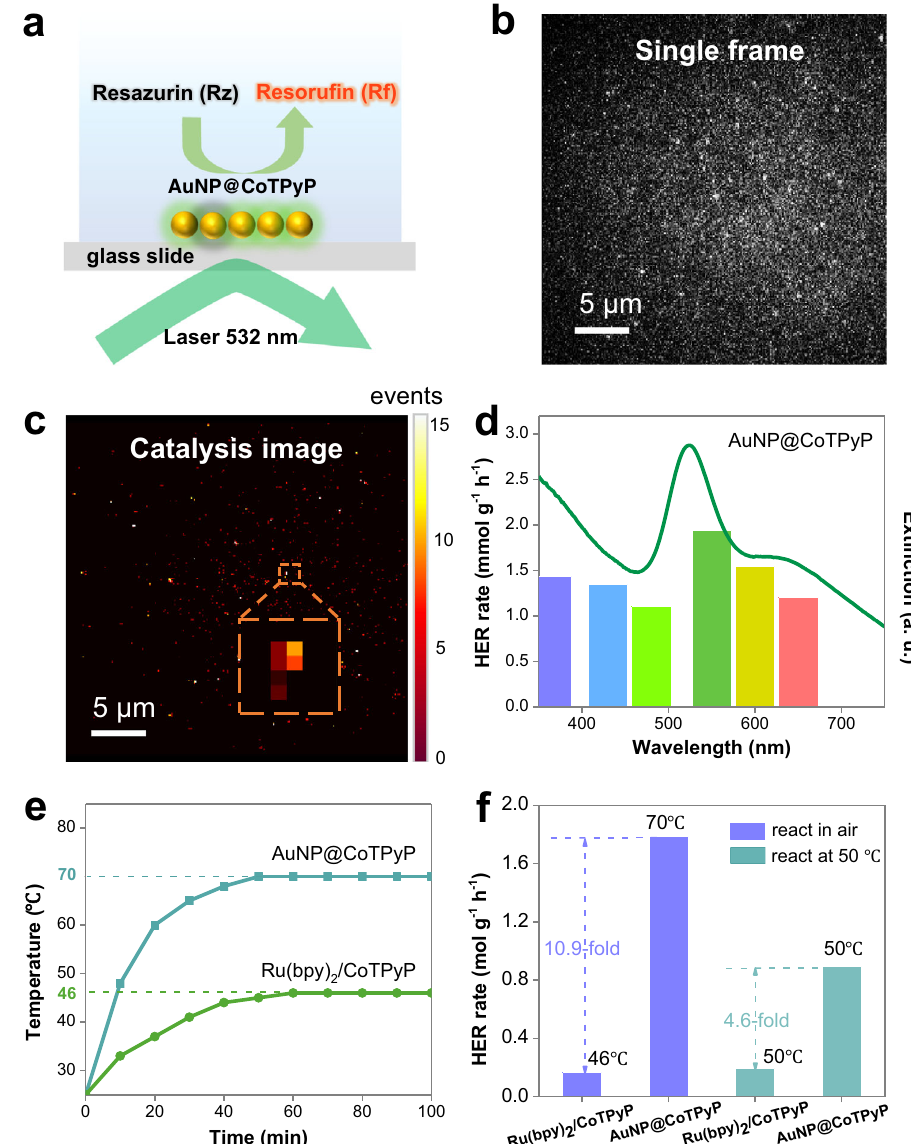
Fig. 4 | Characteristics of plasmon-enhanced catalysis on AuNP@CoTPyP nanostructures.a Scheme of the AuNP@CoTPyP-catalyzed resazurinreductionin SMFM. b Single frame of the AuNP@CoTPyP nanostructure during SMFM. c Reconstructed image of the catalytic active events (10 4 frames were acquired within 200s). d UV − Vis extinction spectrum of AuNP@CoTPyP (CoTPyP